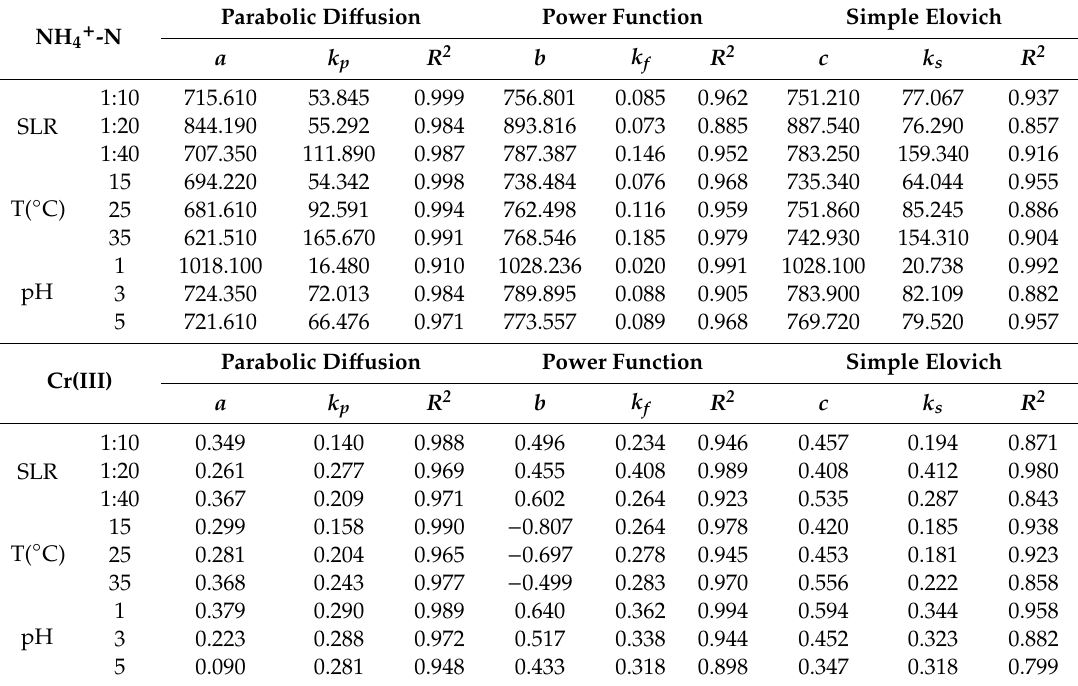
Table 2. Calculated kinetic parameters for Cr(III) and NH 4 + -N release from the tannery sludge. Parabolic Di ff usion Power Function NH 4 + -N